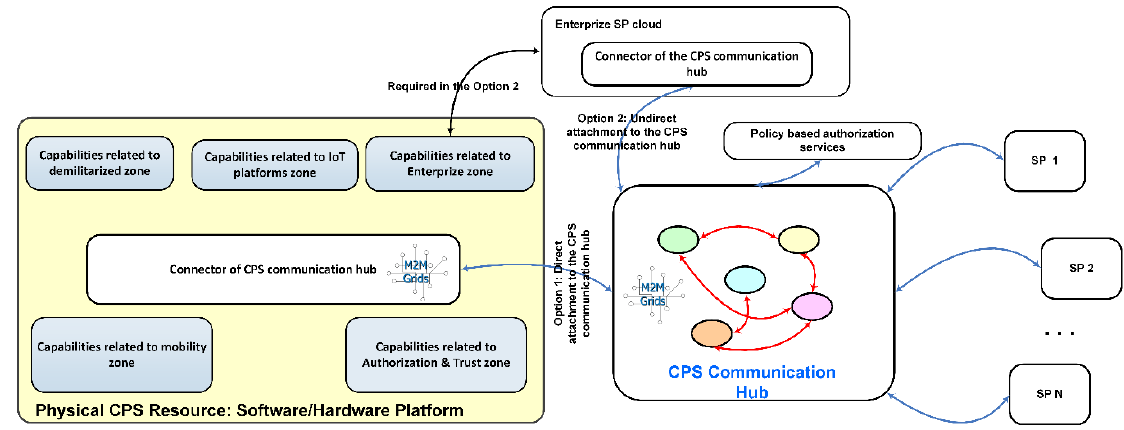
Figure 5. Capabilities of physical CPS resources and options for operation with CPS communication spaces.